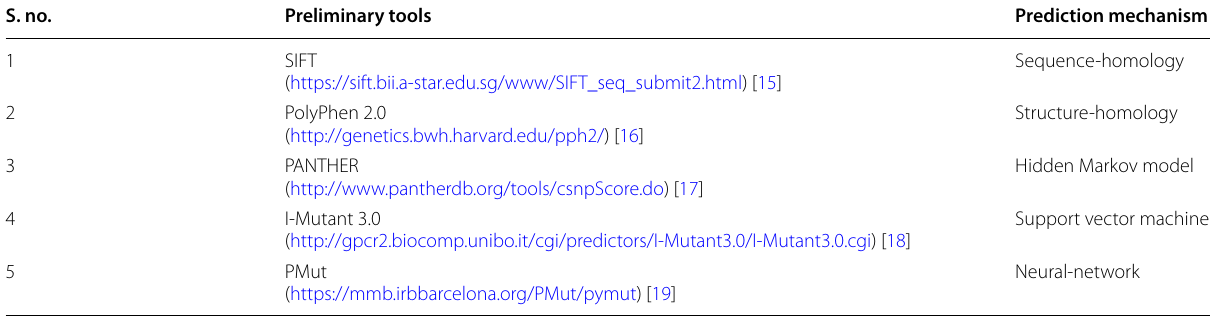
Table 1 List of tools employed for combined analysis using preliminary tools S. no.